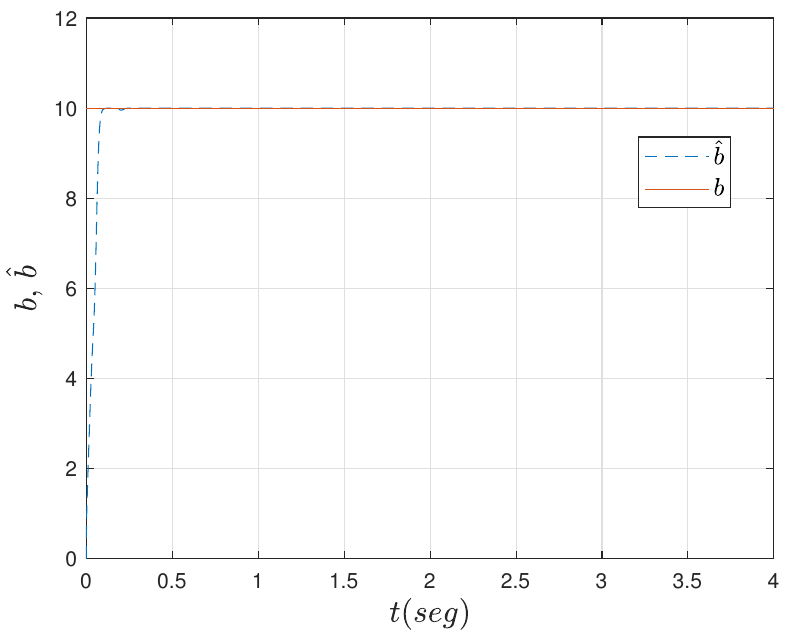
Figure 13. Progression of the convergence for ˆ b